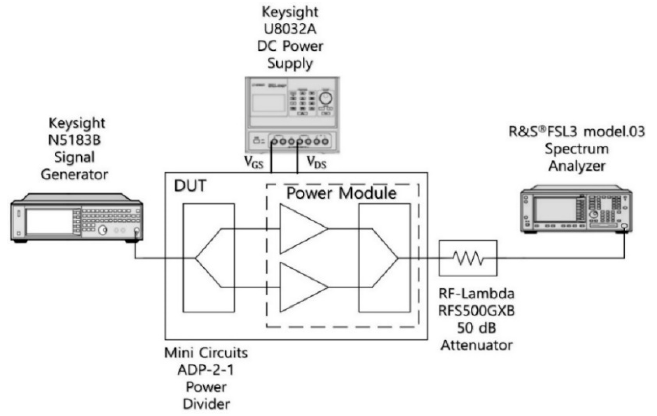
Figure 11. Measurement setup for obtaining the output power and calculating the PAE of the proposed power module.